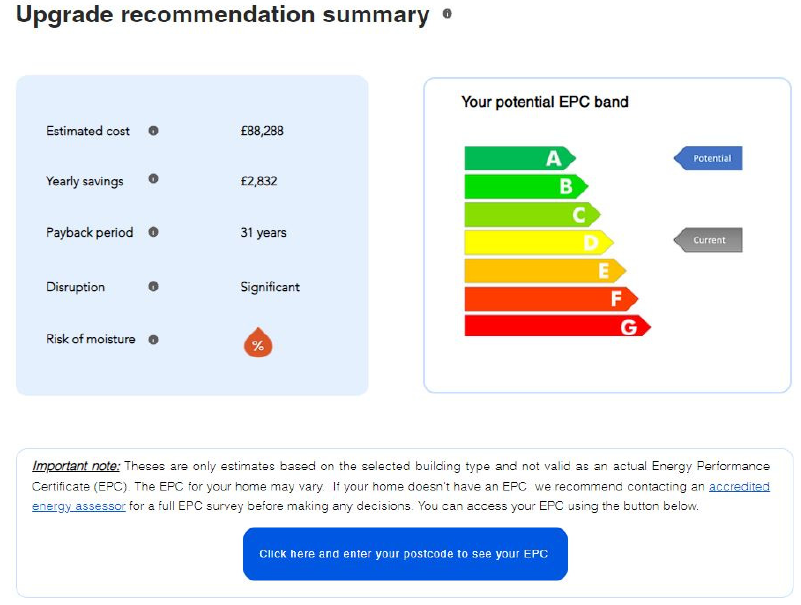
Figure 9. Upgrade recommendation